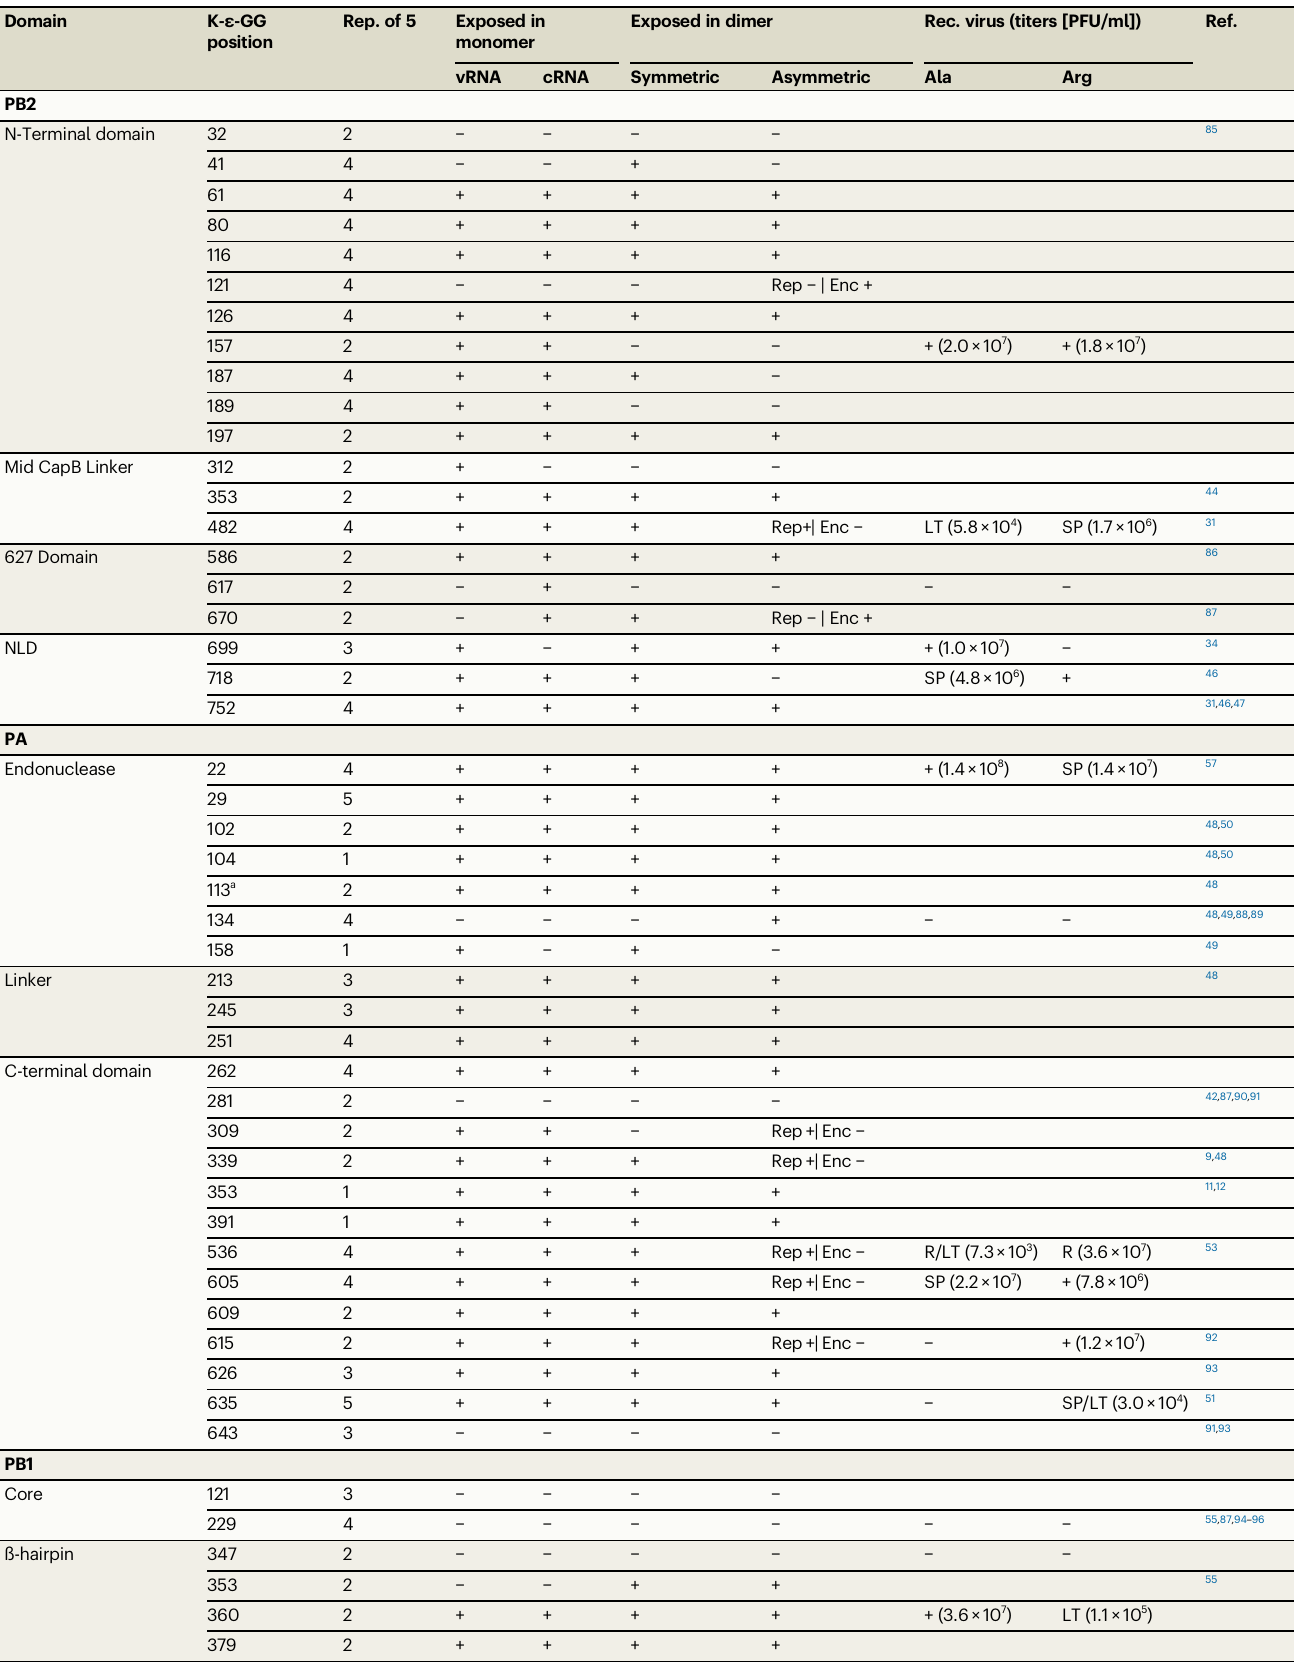
Table 1 | Modi fi ed lysines in the IAV polymerase